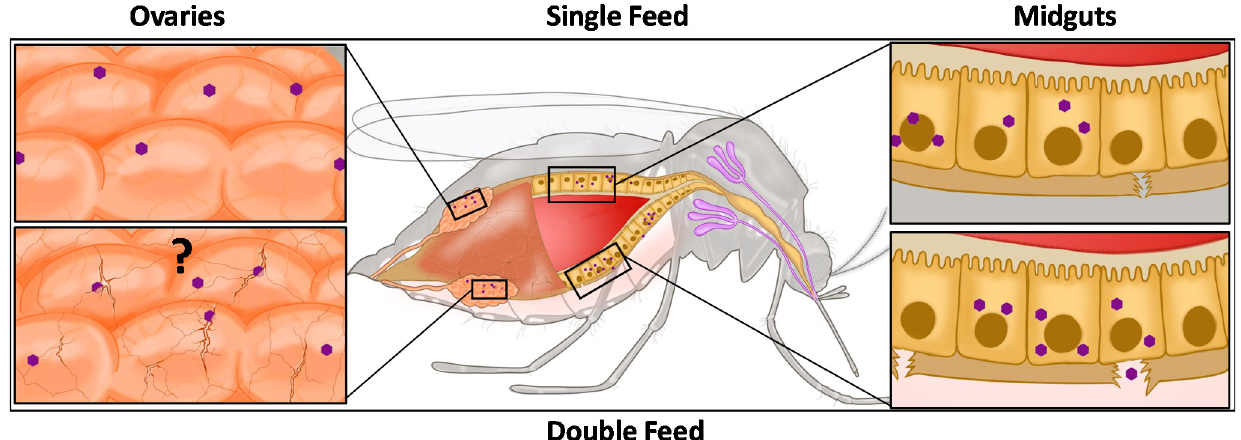
Fig 1. Multiple feeding episodes provide arboviruses opportunities to navigate anatomical barriers within mosquitoes. (Center) Cross section of Ae . aegypti mosquito infected with Zika virus under single-feed (top) and double-feed (bottom) scenarios. A dense AU : PleaseconfirmthattheeditstothesentenceAdensenetworkofproteoglycans ::: arecorrect ; andamendifnecessary : network of proteoglycans, termed the “basal lamina,” provides support and protection to internal tissues such as the mosquito midgut (right inserts) and ovaries (left inserts). Due to pore size limitations, arboviruses cannot easily traverse these structures. However, additional blood feeding results in distention of the midgut tissue inducing micro-perforations in the underlying basal lamina facilitating virus passage to the hemolymph and access to secondary tissues such as the salivary glands. Similarly, blood meal acquisition induces oogenesis and expansion of the ovarian tissue. It is hypothesized that such disruptions in the ovarian basal lamina could provide viruses access to the developing eggs and infection of the progeny via vertical